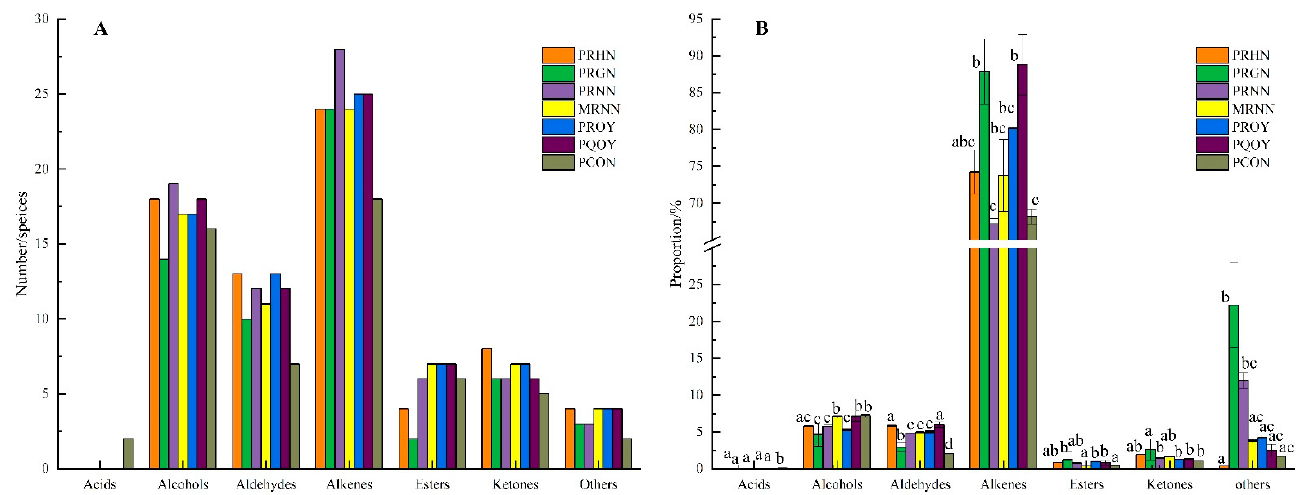
Figure 1. Analysis of species ( A ) and proportion ( B ) of VOCs among Citrus sinensis ‘hongjiang’. a, b, c: Different letters represents a significant difference. Table 1. The composition and relative contents of volatile organic compounds (VOCs) among Citrus sinensis ’hongjiang’.